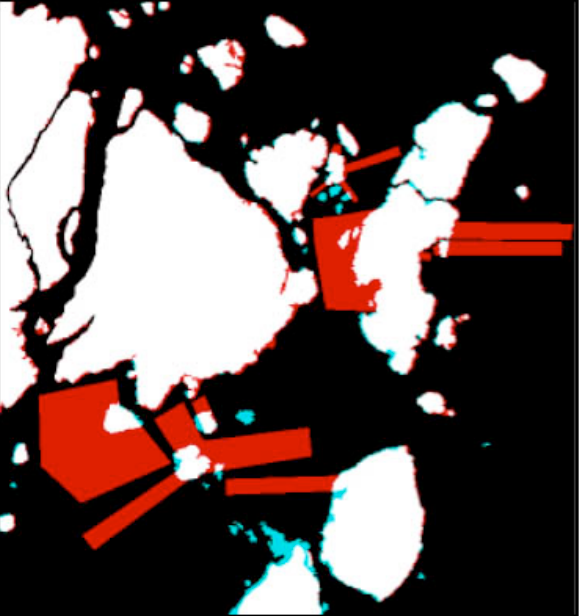
Figure 3. Cloud spike removal from GDEM3 in Gabon, height as brightness.